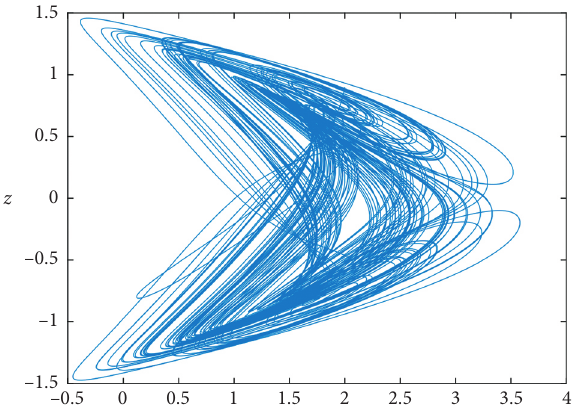
Figure 20: Dynamic behavior of fractional financial chaotic model with α � 0 . 95.